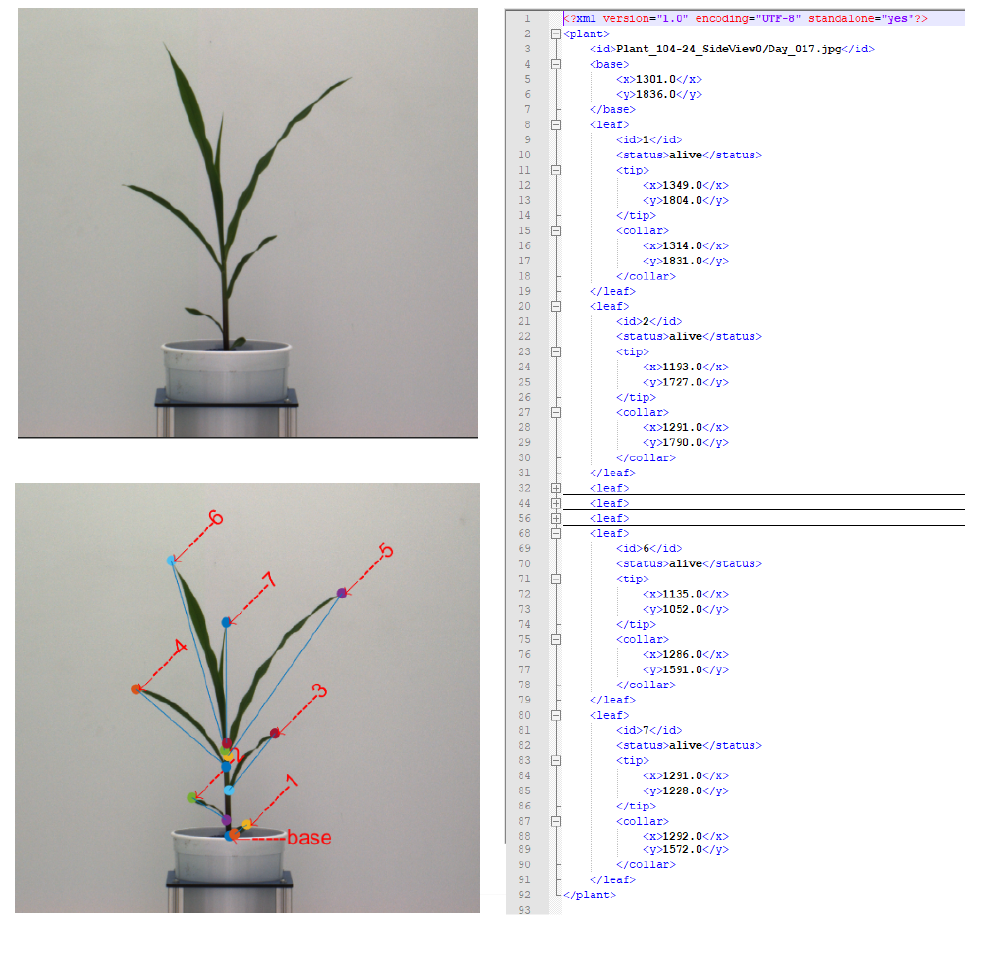
Figure 6. An example of the ground truth of the University of Nebraska-Lincoln Component Plant Phenotyping Dataset (UNL-CPPD): ( top-left ) original image; ( bottom-left ) annotated image; and ( right ) XML